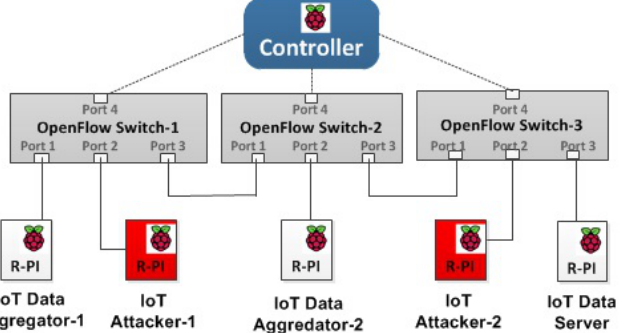
Figure 5. The SDN-based IoT architecture of the testbed used for the emulation of DDoS